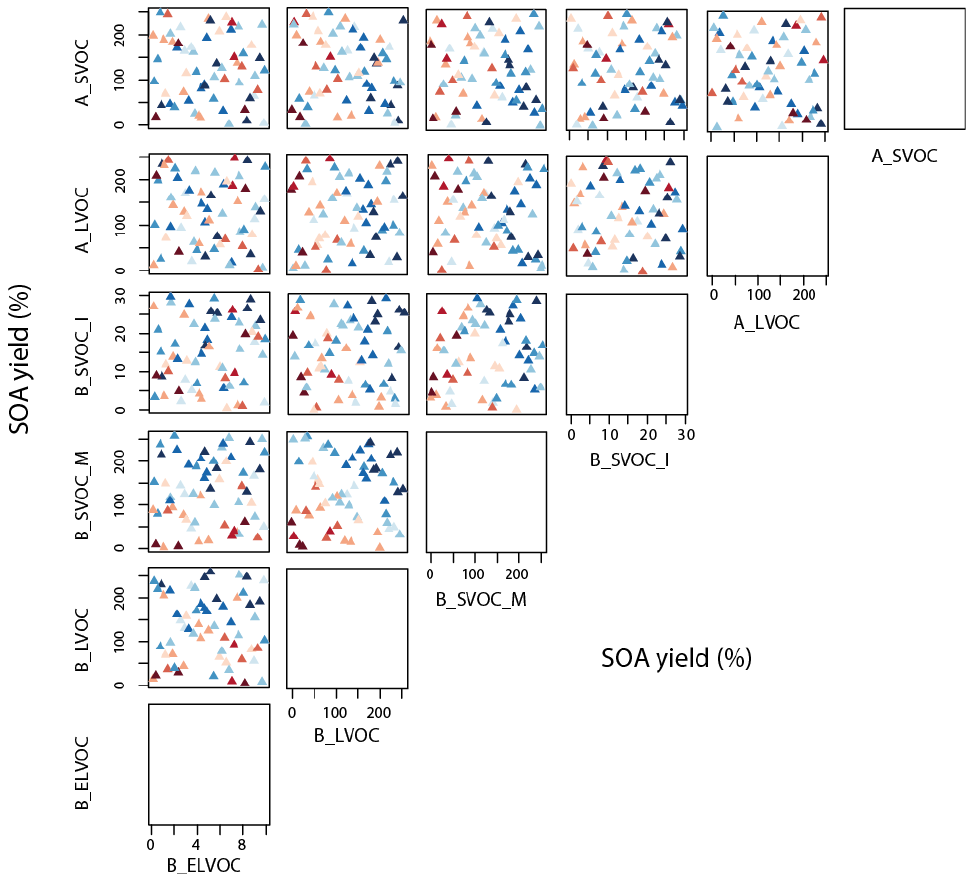
Figure 12. Taylor skill score for model simulations against OA observations across the 6-D parameter space. The x and y axes for a subplot show the total range of reaction yields (%) over which each of the two parameters (as indicated by the plot labels at the top and right for each subplot respectively) is perturbed in the ensemble. Each triangle in a subplot represents a simulation and the color of the triangle indicates its Taylor skill score for OA. Darker shades of blue indicate low/poor Taylor skill score and darker shades of red represent a high/good Taylor skill score. Figure A5 shows the same plot with ensemble members numbered. Note the axis for B_ELVOC shows the scaling factor for B_ELVOC yields. Axes for the rest show the corresponding ox-VOC